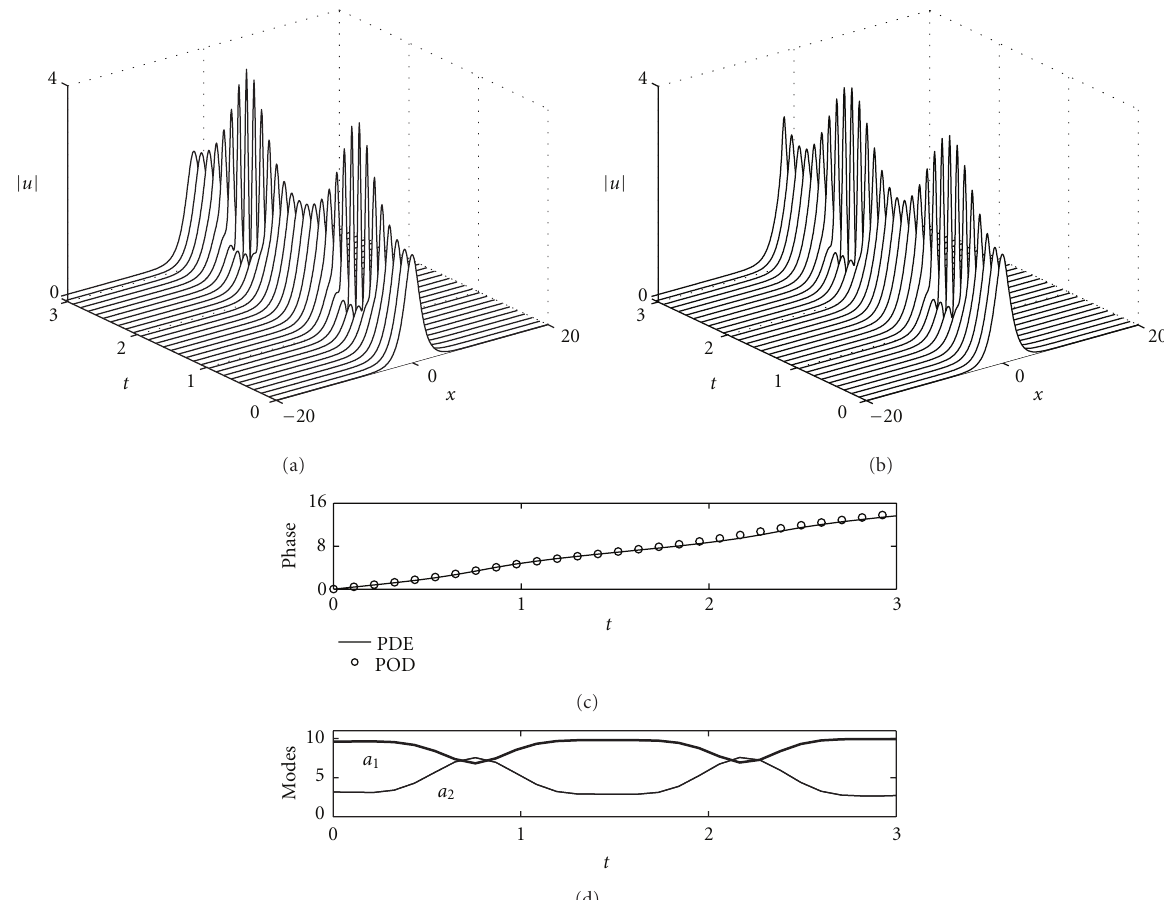
Figure 6: Comparison of (a) full PDE dynamics and (b) two-mode POD dynamics. In the bottom two figures, the phase of the pulse evolution at x = 0 (middle panel) is plotted for the full PDE simulations and the two-mode dynamics along with the nonlinear oscillation dynamics of a 1 ( t ) and a 2 ( t ) (bottom